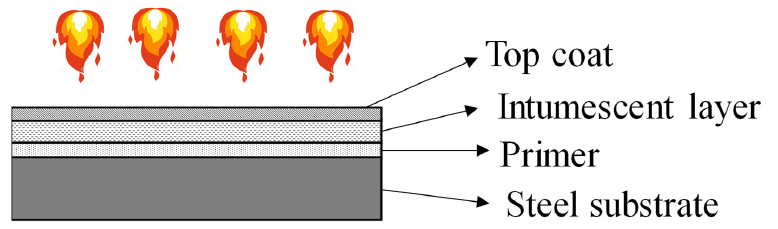
Figure 1. Intumescent system.